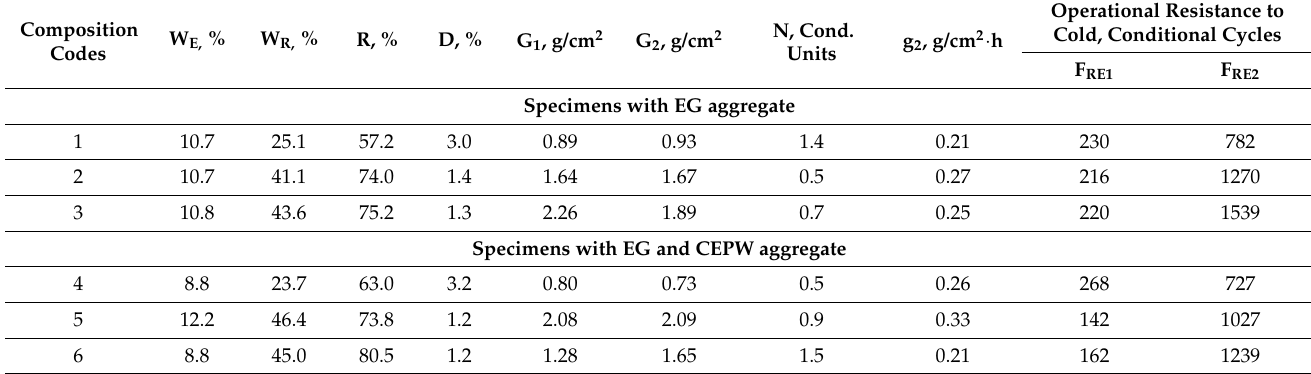
Table 7. Average values of LWC structural indicators and calculated operational frost